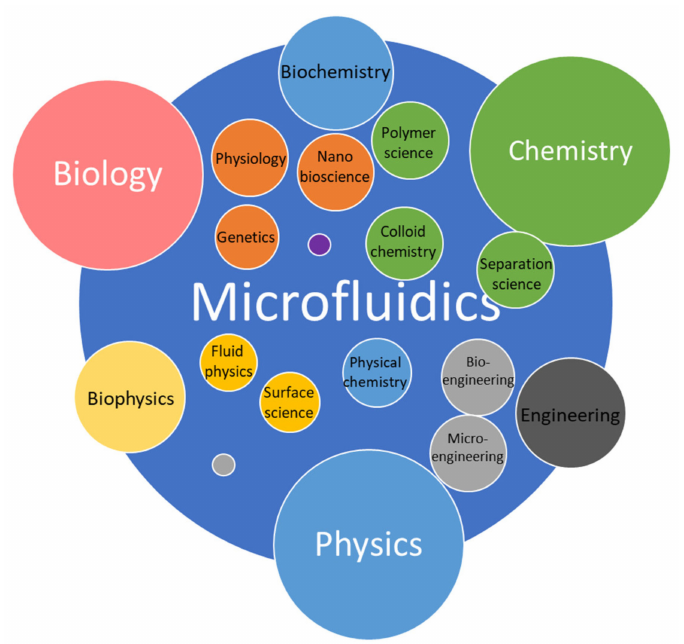
Figure 8. Microfluidics shows a wide range of applications, allowing fundamental studies of pro- cesses and systems at the molecular-scale in science and engineering, exhibiting the potential for developing new systems and technologies for an ever-growing list of applications at the interface of different fields of research, namely, physics, chemistry, and